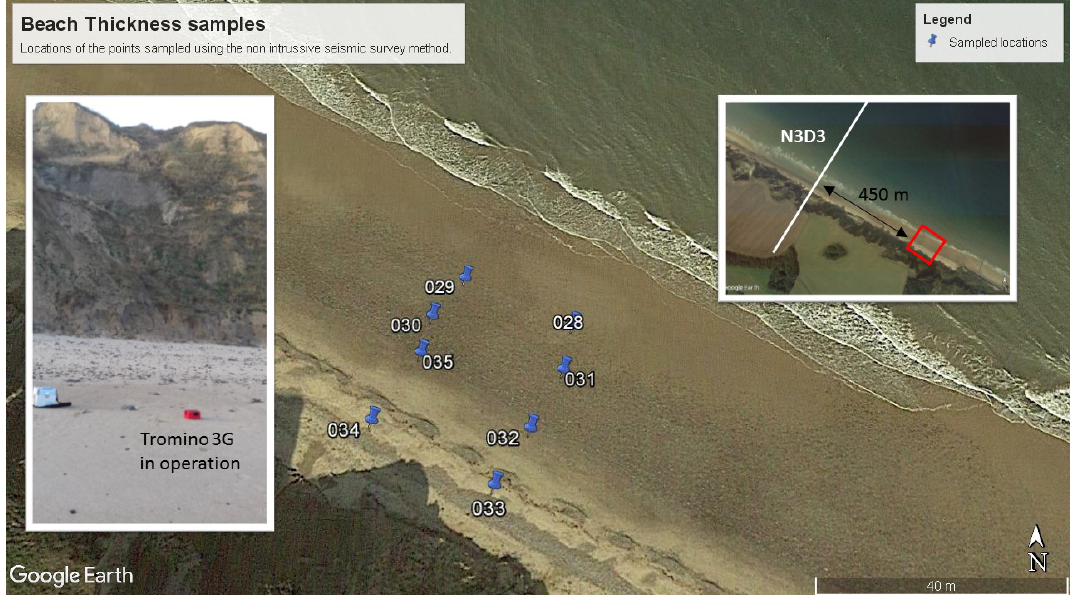
Figure 4. Location of the points sampled with the Passive Seismic Survey